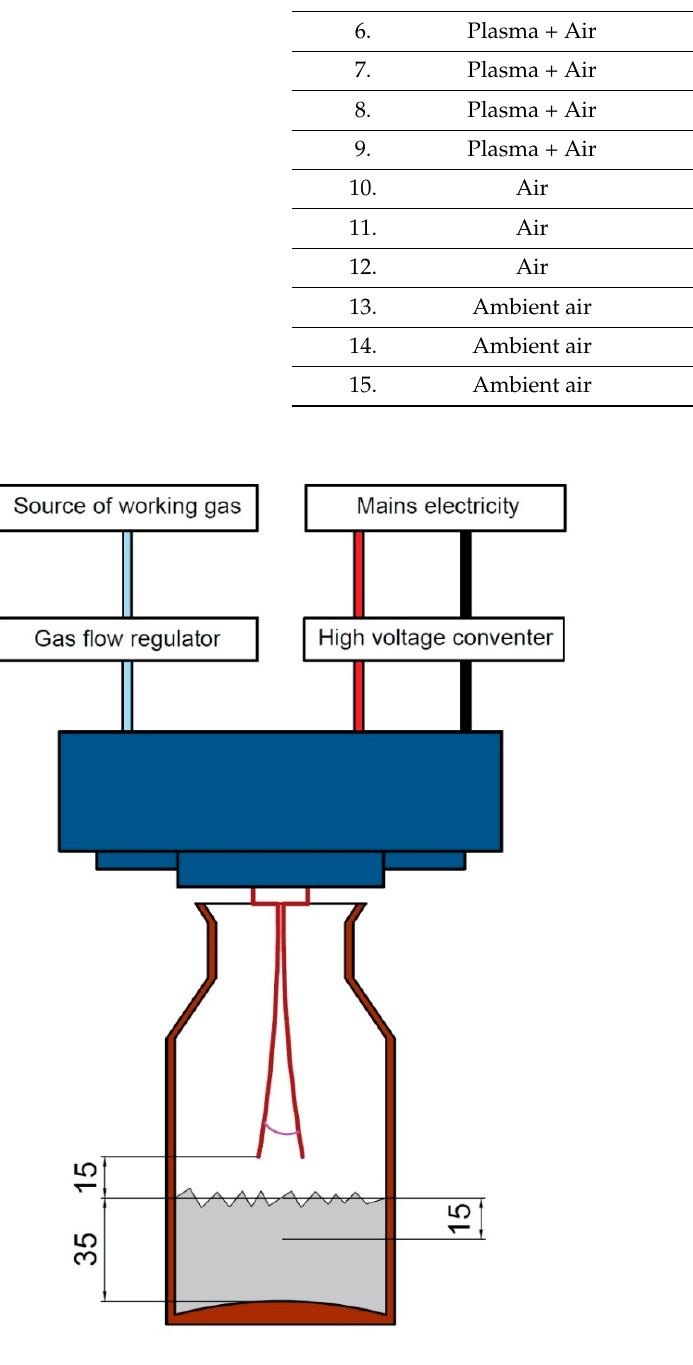
Figure 2. Experimental setup (units in mm).